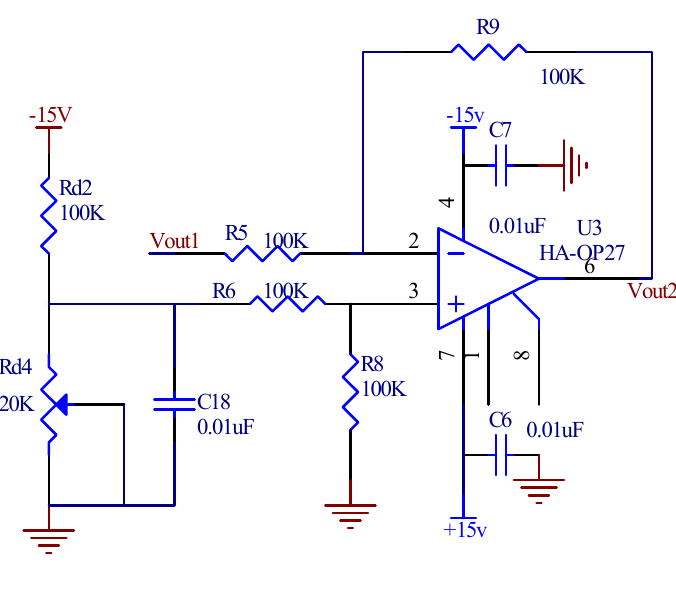
Figure 9. The circuit of differential